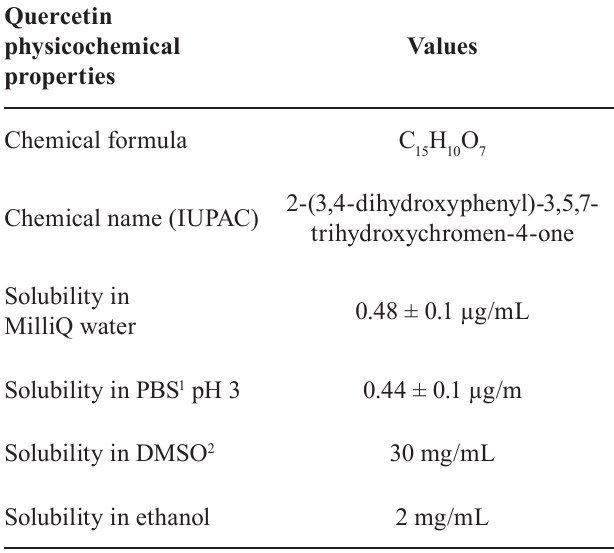
TABLE II - Physicochemical properties of quercetin (Kumar et al. 2014)